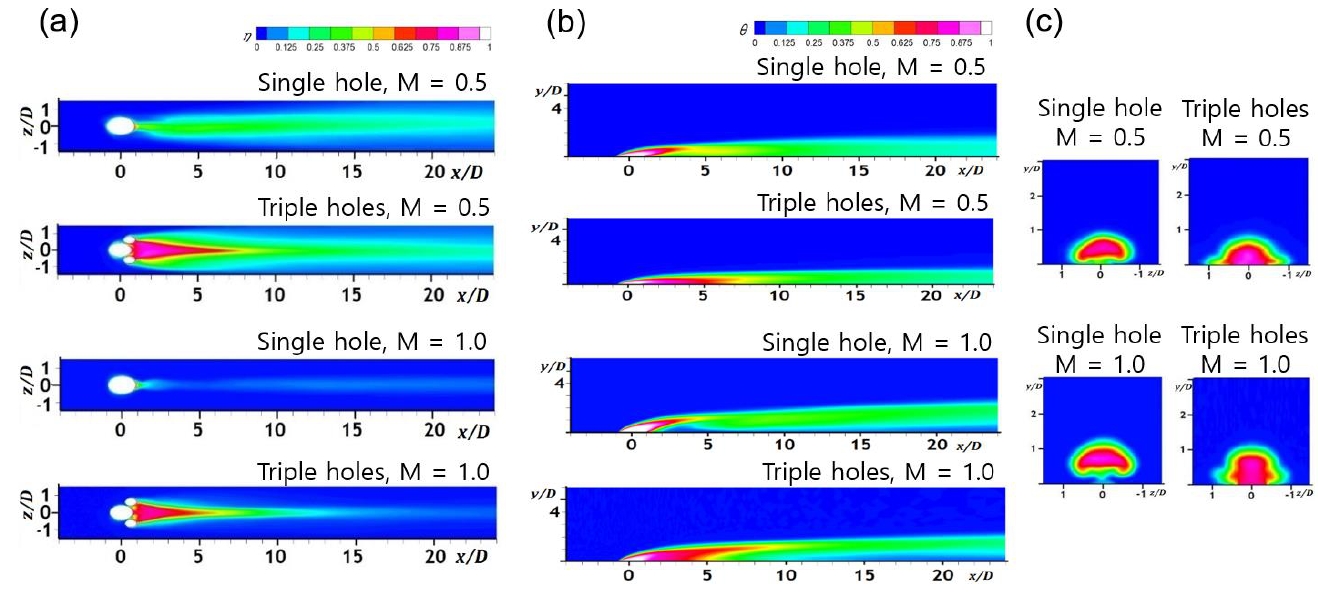
Figure 9. Film cooling with triple holes [73]: ( a ) film-cooling effectiveness, ( b ) temperature fields at z / D = 0, and ( c ) temperature fields at x / D = 2.5.